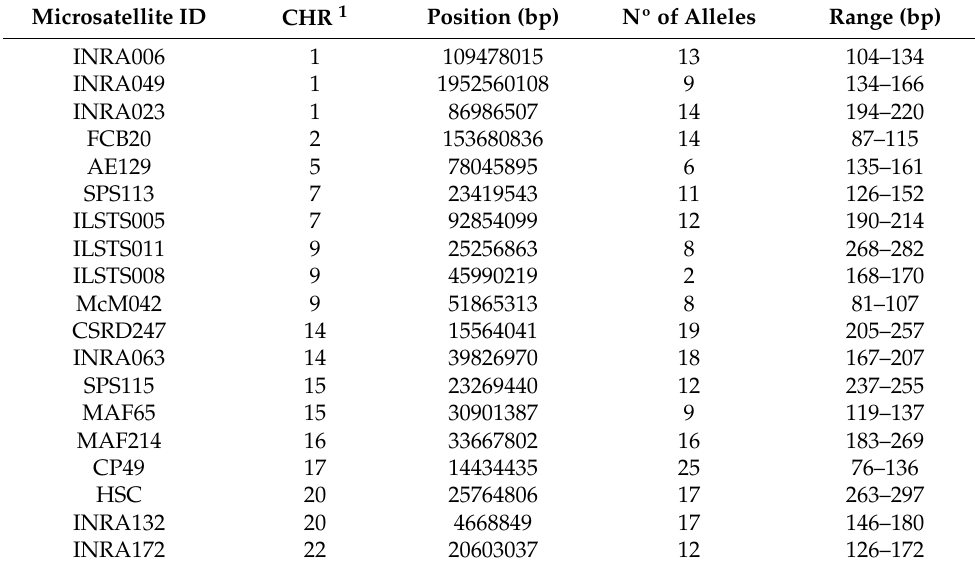
Table 1. Characteristics of microsatellite markers used in the present study. For each microsatellite marker, the microsatellite ID, genome position (Oar_v3.1), number of alleles per marker, and allele length range expressed in base pairs are shown in the